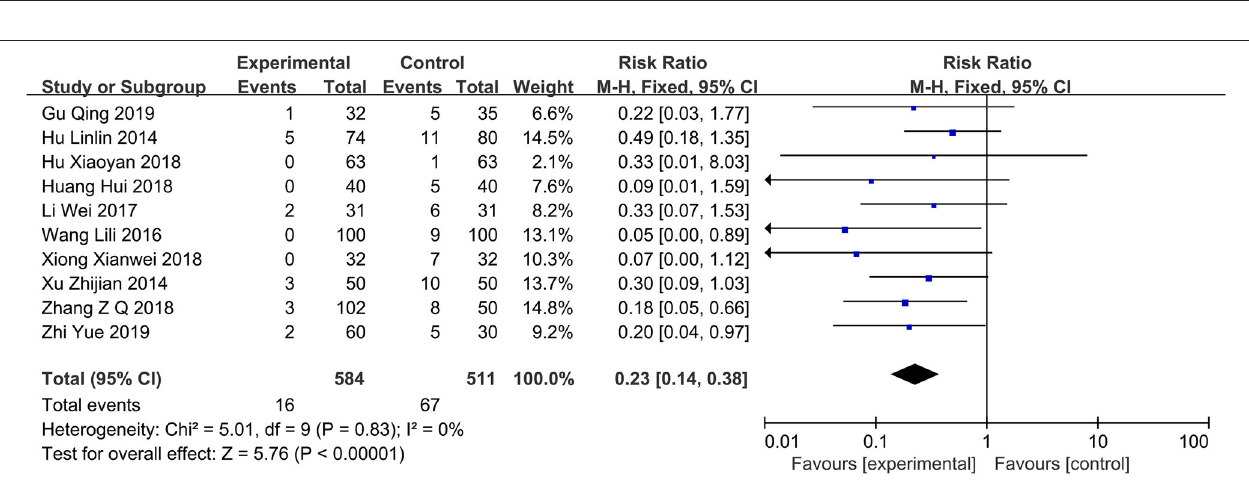
FIGURE 5 | Forest plot of the incidence of gastrointestinal bleeding between the PPI treatment group and the conventional treatment group. PPI, proton-pump